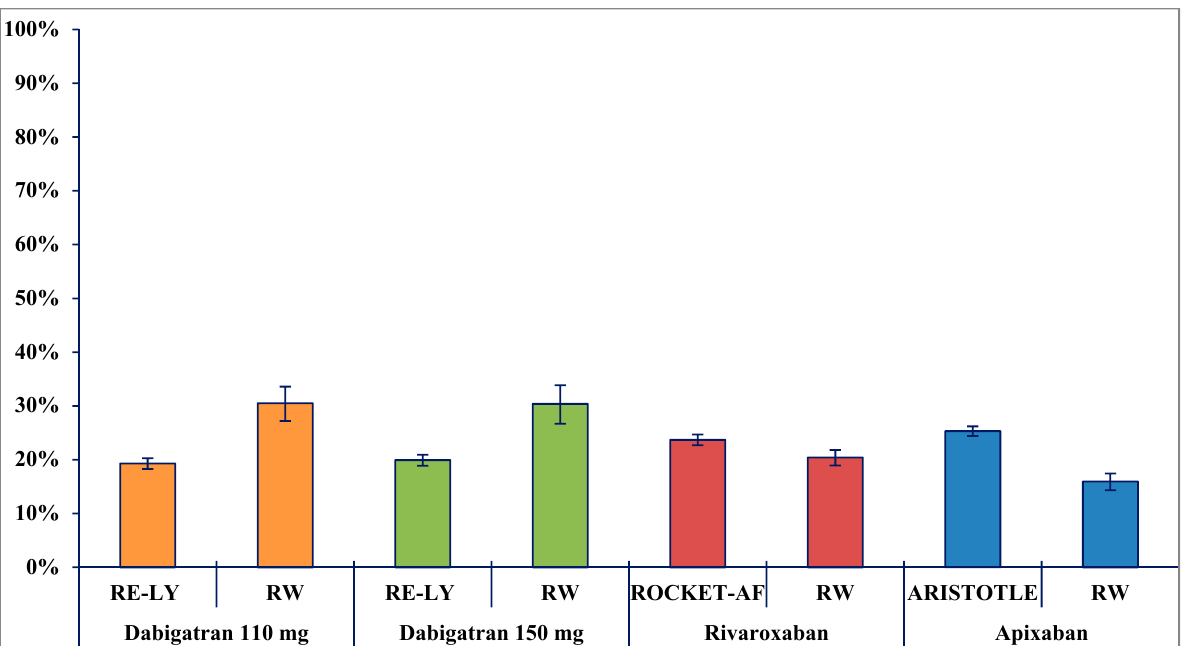
Figure 1. Distribution of direct oral anticoagulant (DOAC) discontinuers in pivotal RCT populations and in Palermo RW populations during the follow-up. Note: all differences were statistically significant ( p -value < 0.001). Median (interquartile range–IQR) follow-up—years: Dabigatran 110 mg: Randomized Evaluation of Long-Term Anticoagulation Therapy (RE-